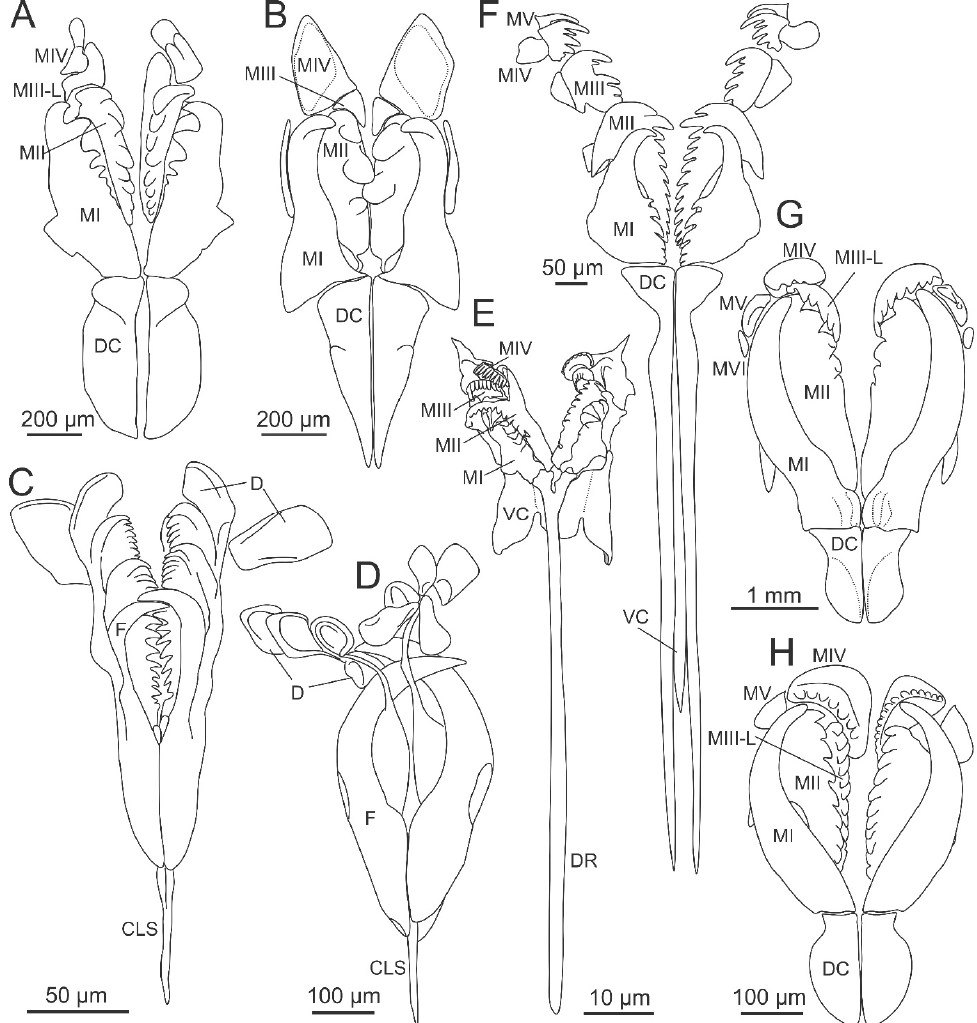
Figure 3. Diversity of maxillae in Eunicida. ( A ) Hartmaniella sp., Hartmaniellidae; ( B ) Augeneria sp., Lumbrineridae; ( C ) Ophryotrocha mammillata Ravara et al., 2015, Dorvilleidae, P-type maxillae; ( D ) the same, K-type maxillae ( E ) Histriobdella homari Van Beneden, 1858, Histriobdellidae; ( F ) Arabella mutans (Chamberlin, 1919), Oenonidae; ( G ) Eunice roussaei Quat- refages, 1866, Eunicidae; ( H ) Paradiopatra fragosa (Ehlers, 1887), Onuphidae. CLS—carrier-like structure, D—free denticles, DC—dorsal carrier, DR—dorsal rod, F—forceps, MIII-L—left maxillae III, MI–MV—maxillae I–V, VC—ventral carrier. ( C–D ) modified from Ravara et al. [31]; ( H ) modified from Budaeva and Fauchald [32]. The different jaw morphologies also have different biomechanics with implications for food capturing and shredding [33]. In maxillae bearing carriers of at least Lumbrineri- dae and Onuphidae (Figure 3B,H), those plates attached to the carriers are primary max- illae (maxillae I, II in both families and unpaired III in Onuphidae) responsible for catching and shredding (exclusive of serrated plates) food items. The unpaired serrated primary maxillae III in onuphid improves the breaking of food with different properties. The in- terlocking mechanism, present at the posterior end of maxillae I in both families, prevents slipping of the plates and it is an important mechanism in capturing moving food [33].